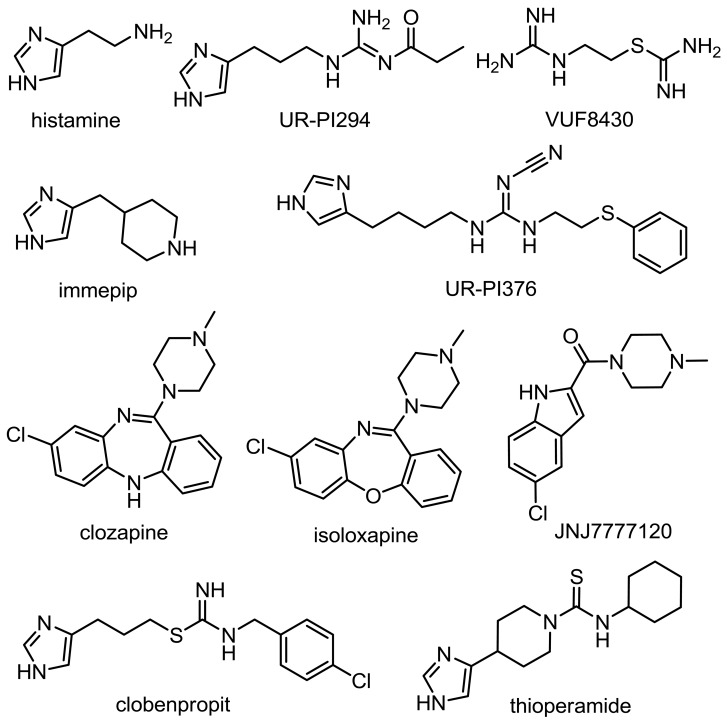
Structures of the investigated H4R ligands.